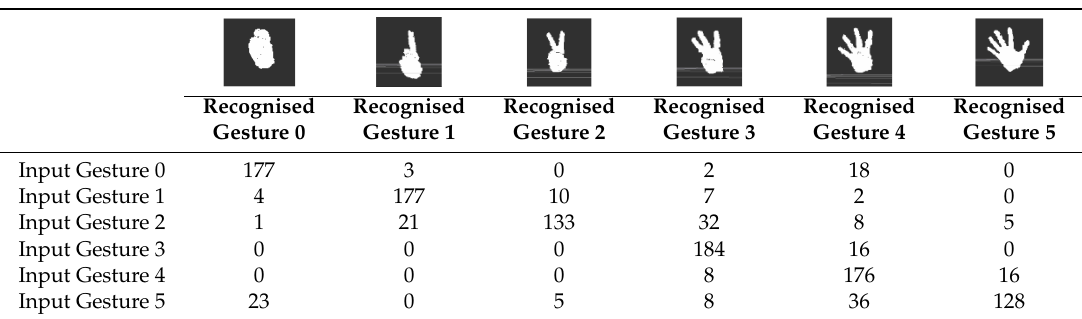
Table 4. Confusion matrix computed during the recognition process for the identification of six gestures of the right hand, with 200 samples per